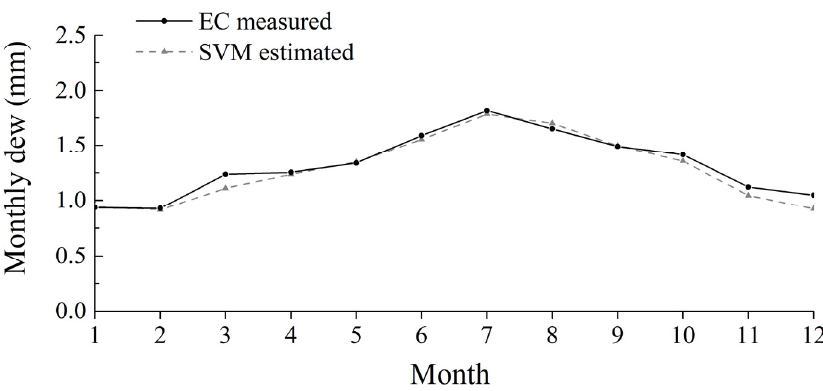
Figure 7. The average dew of each month estimated and EC measured for 2013–2017 SVM.